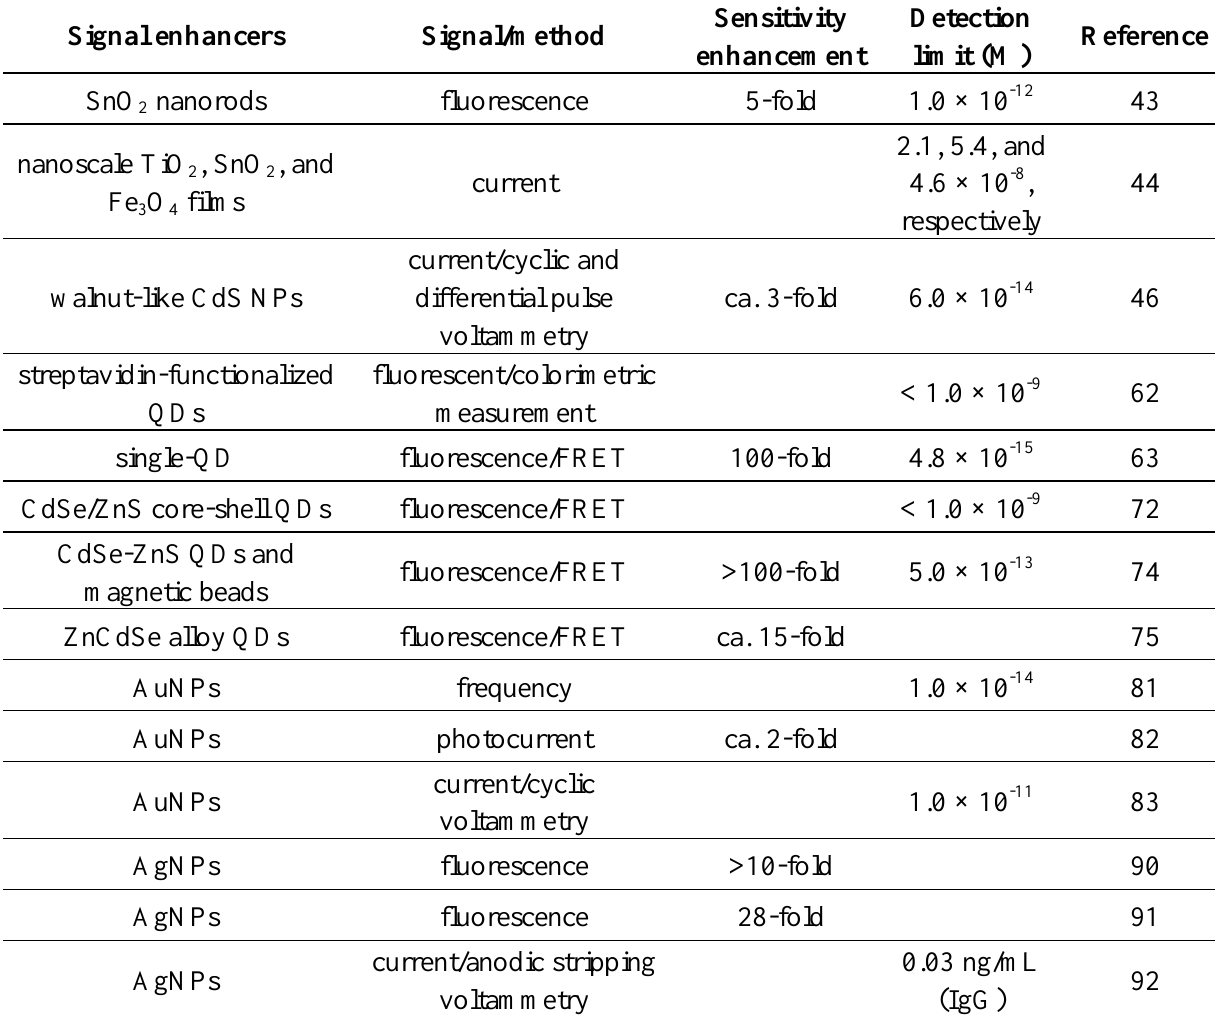
Table 1. Summary of signal-enhancement based on nanomaterials and